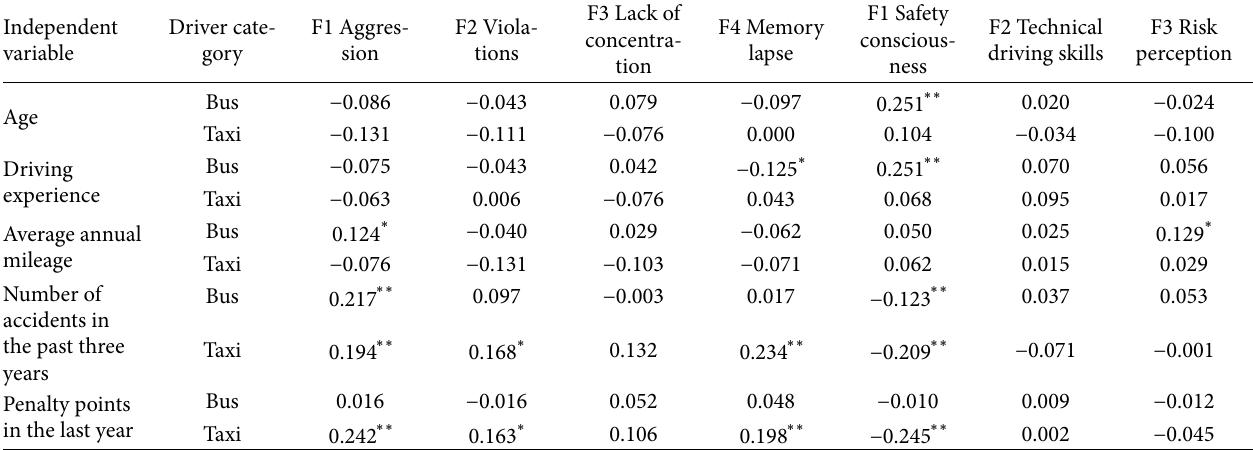
Table 4: Correlation analysis of personal characteristics, driving behaviors and driving skills of drivers.